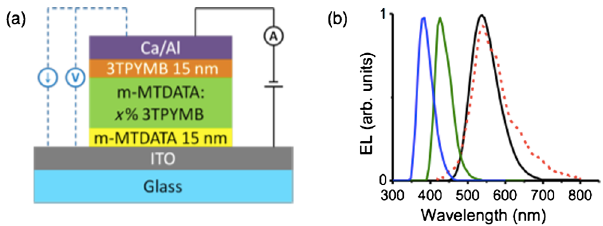
FIG. 2. Exciplex device structure and emission spectrum. (a) Schematic device structure showing the two measurement modes we use. The solid circuit is for a constant-voltage measure- ment, whereas the dashed circuit is for a constant current. (b) Electroluminescence spectrum for our device (red dashed line), compared with exciplex emission (solid black line) and exciton